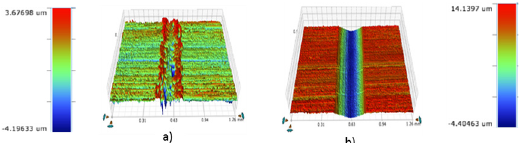
Figure 10: Profilometry results for the as-received sample in a) dry condition and b) corrosive medium.